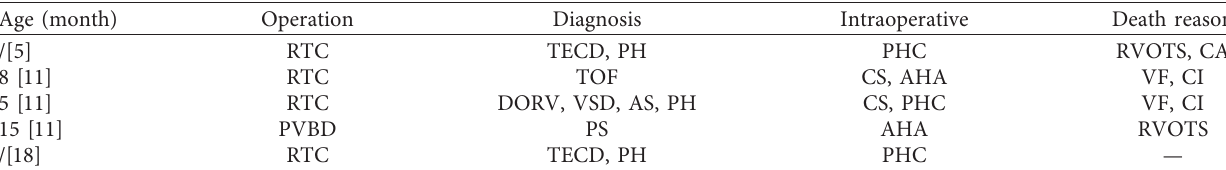
Table 6: Fatal cases.